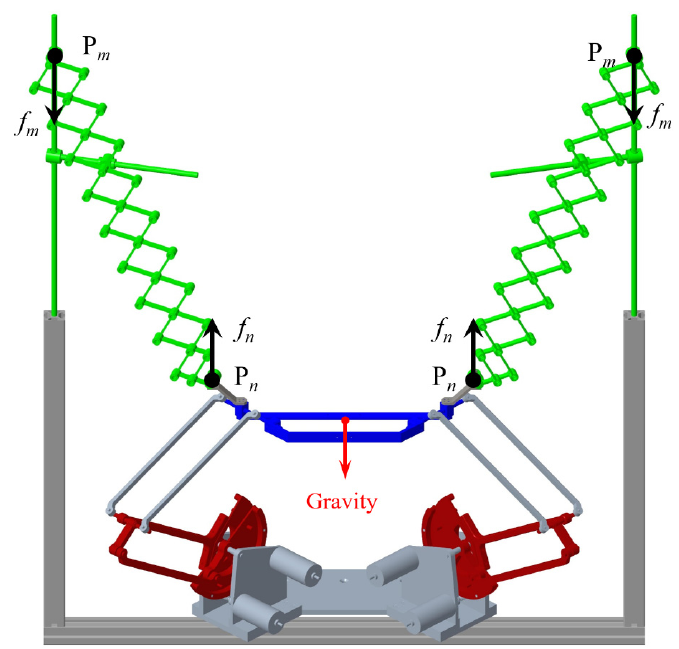
Figure 4. Final system with passive compensation.